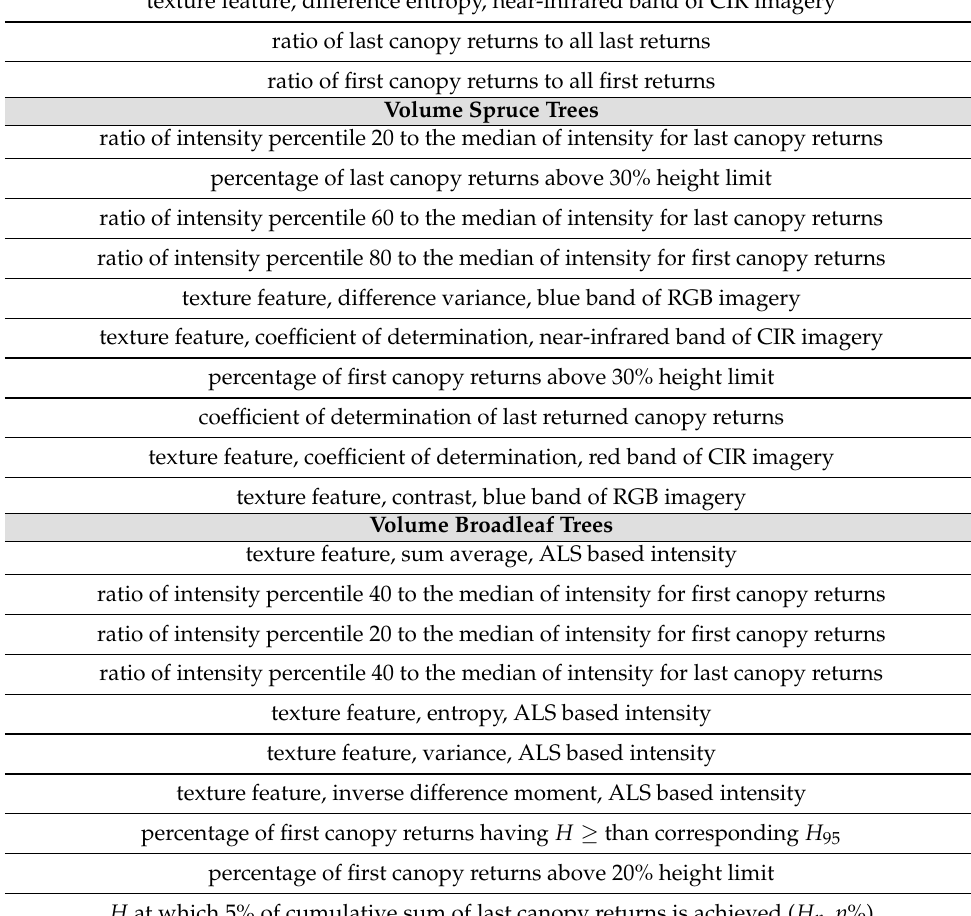
Table 1. Cont. texture feature, difference entropy, near-infrared band of CIR imagery ratio of last canopy returns to all last returns ratio of first canopy returns to all first returns Volume Spruce Trees ratio of intensity percentile 20 to the median of intensity for last canopy returns percentage of last canopy returns above 30% height limit ratio of intensity percentile 60 to the median of intensity for last canopy returns ratio of intensity percentile 80 to the median of intensity for first canopy returns texture feature, difference variance, blue band of RGB imagery texture feature, coefficient of determination, near-infrared band of CIR imagery percentage of first canopy returns above 30% height limit coefficient of determination of last returned canopy returns texture feature, coefficient of determination, red band of CIR imagery texture feature, contrast, blue band of RGB imagery Volume Broadleaf Trees texture feature, sum average, ALS based intensity ratio of intensity percentile 40 to the median of intensity for first canopy returns ratio of intensity percentile 20 to the median of intensity for first canopy returns ratio of intensity percentile 40 to the median of intensity for last canopy returns texture feature, entropy, ALS based intensity texture feature, variance, ALS based intensity texture feature, inverse difference moment, ALS based intensity percentage of first canopy returns having H ≥ than corresponding H 95 percentage of first canopy returns above 20% height limit H at which 5% of cumulative sum of last canopy returns is achieved ( H p , p